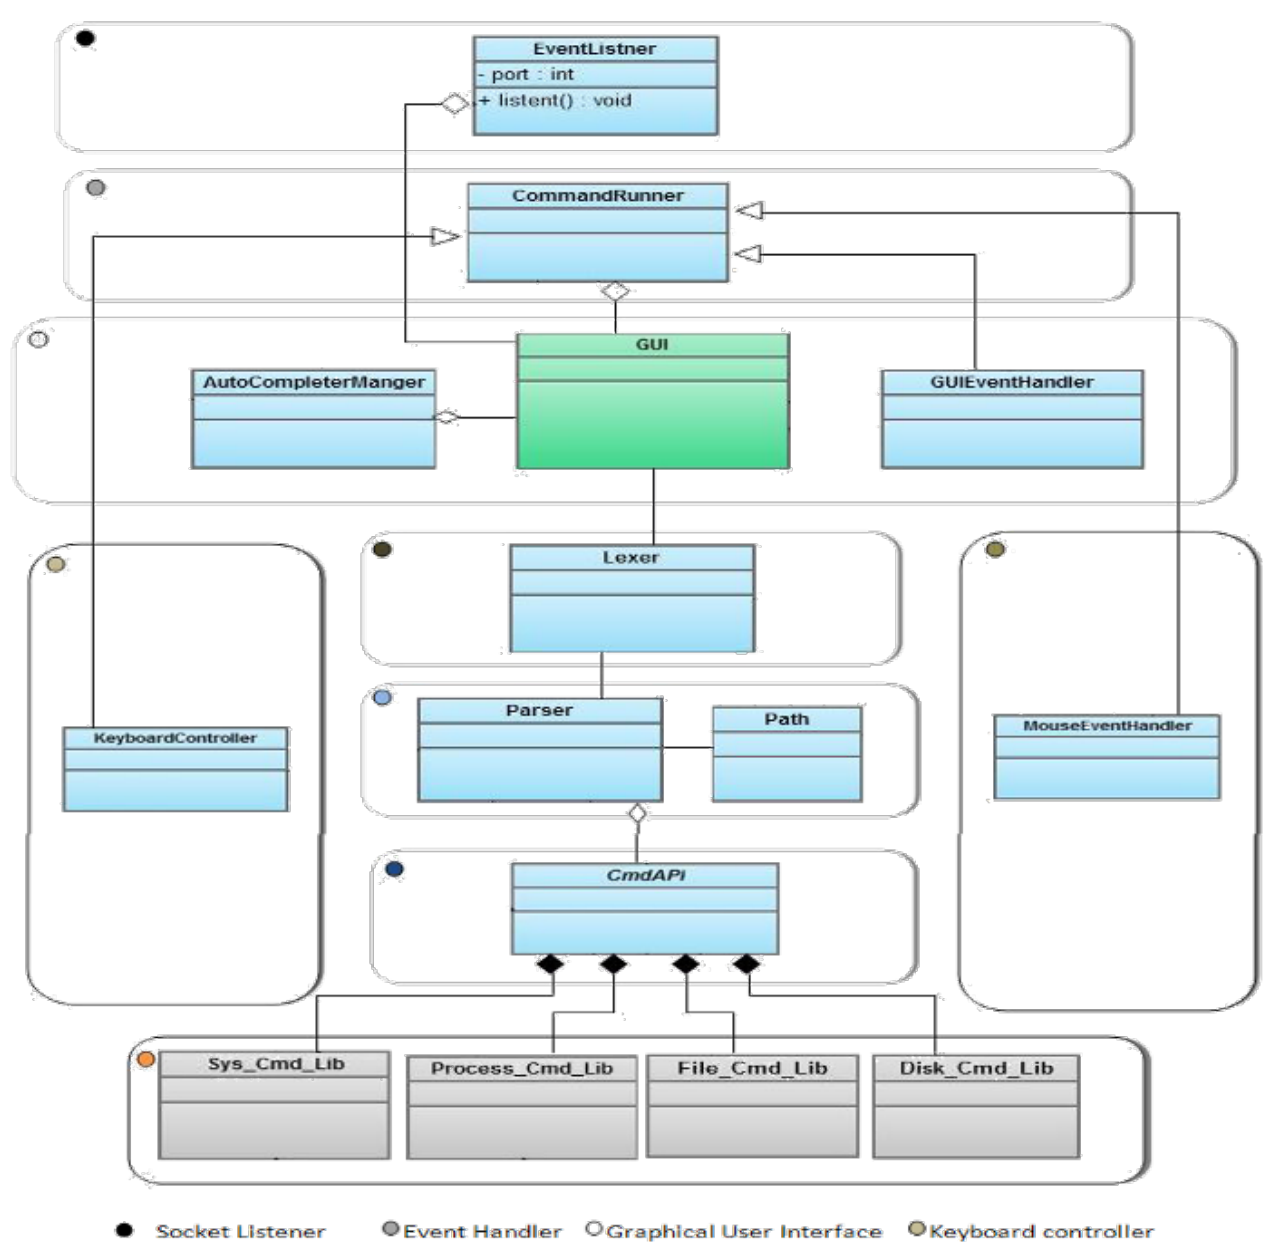
Figure 6. Class diagram of the proposed